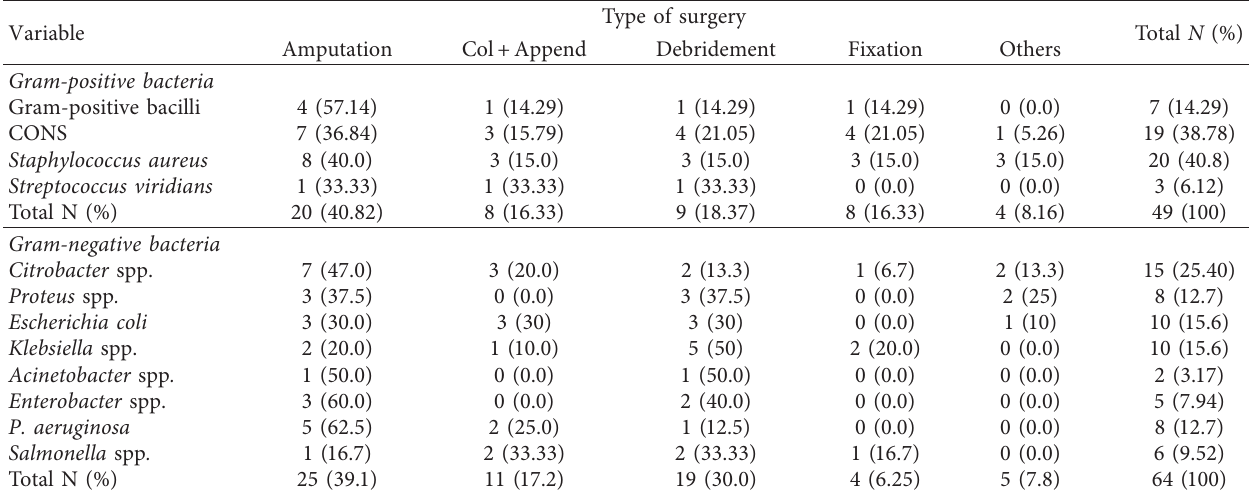
Table 2: Distribution of bacterial isolates in relation to type of operation among patients in surgical wards at the Halibet and the Orotta National Referral Hospital in Asmara, Eritrea,